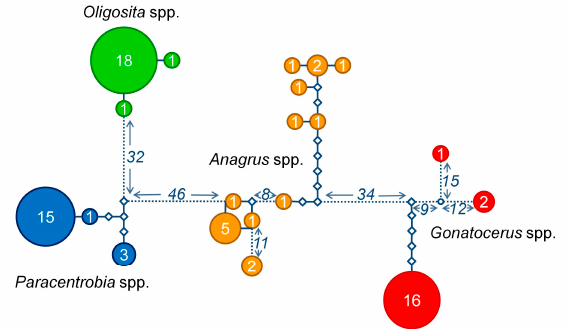
Figure 4. Overall cytochrome c oxidase I (COI) haplotype distance. Network representing the number of substitutions between the different COI sequences obtained from different parasitoid genera: Paracentrobia (blue); Oligosita (green); Anagrus (orange); and Gonatocerus (red). The sample size for each haplotype is written in the respective circle. Each diamond represents a substitution. The numbers next to the dotted lines are the number of substitutions not represented in detail in the figure. The degrees of genetic diversity found in the genera Anagrus and Gonatocerus sequences were particularly high. Within group pairwise distances were 0.075 ± 0.012 SE (28S rRNA gene) and 0.050 ± 0.009 SE (COI gene) for Anagrus , and 0.069 ± 0.012 SE (28S rRNA gene) and 0.100 ± 0.016 SE (COI gene) for Gonatocerus . By contrast, within group pairwise distances were 0.000 ± 0.000 (28S rRNA gene) and 0.005 ± 0.003 SE (COI gene) for Oligosita , and 0.001 ± 0.001 SE (28S rRNA gene) and 0.009 ± 0.004 SE (COI gene) for Paracentrobia (Figure 5). Paracentrobia and Oligosita were significantly different from the congeneric Chalcidoidea, but not from the conspecific Chalcidoidea (Figure 5, Table 2). The genetic differences within Gonatocerus and Anagrus were in the same order of magnitude as the congeneric Chalcidoidea data.